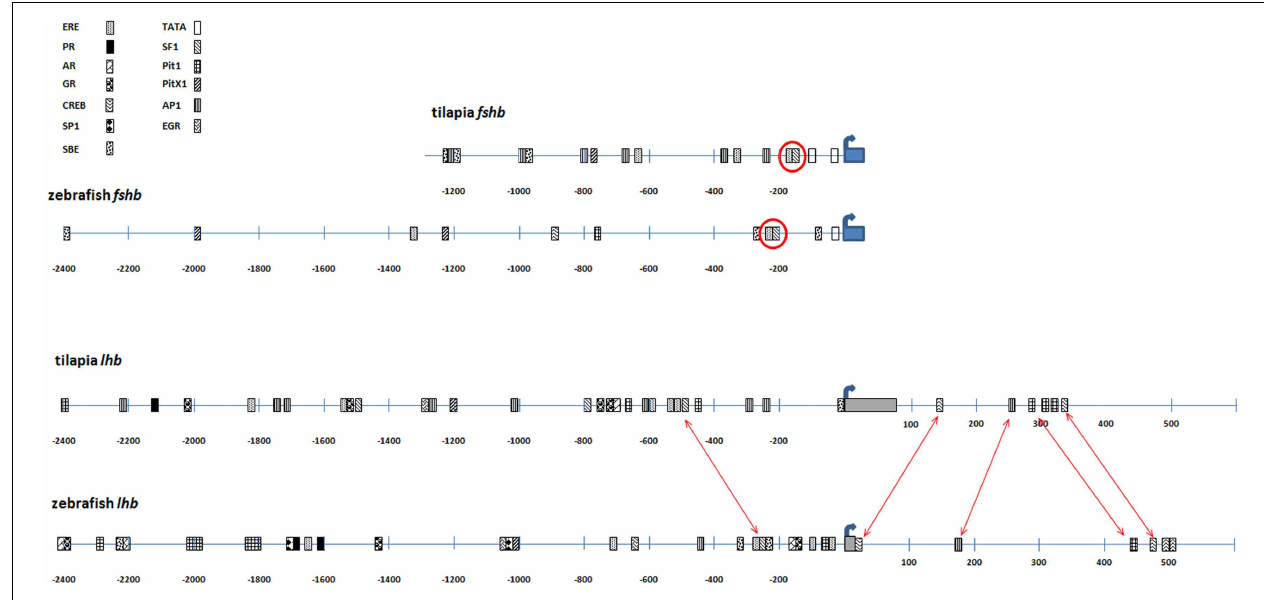
commonTFB sites were identified in the first introns of both species. CommonTFB sites are indicated by arrows.Thick blue arrow indicates transcription start site. Gray box, first exon; ERE, estrogen-responsive element; PR, progesterone receptor-binding site; AR, androgen receptor-binding site; GR, glucocorticoid receptor-binding site; SBE, smad-binding element; EGR, early growth response-binding